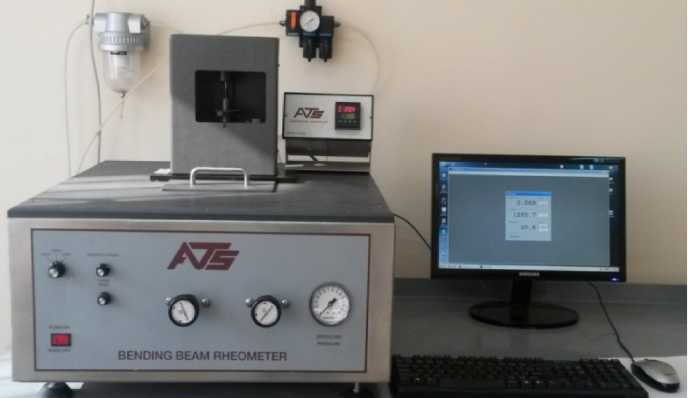
Figure 1. Bending beam rheometer (BBR).